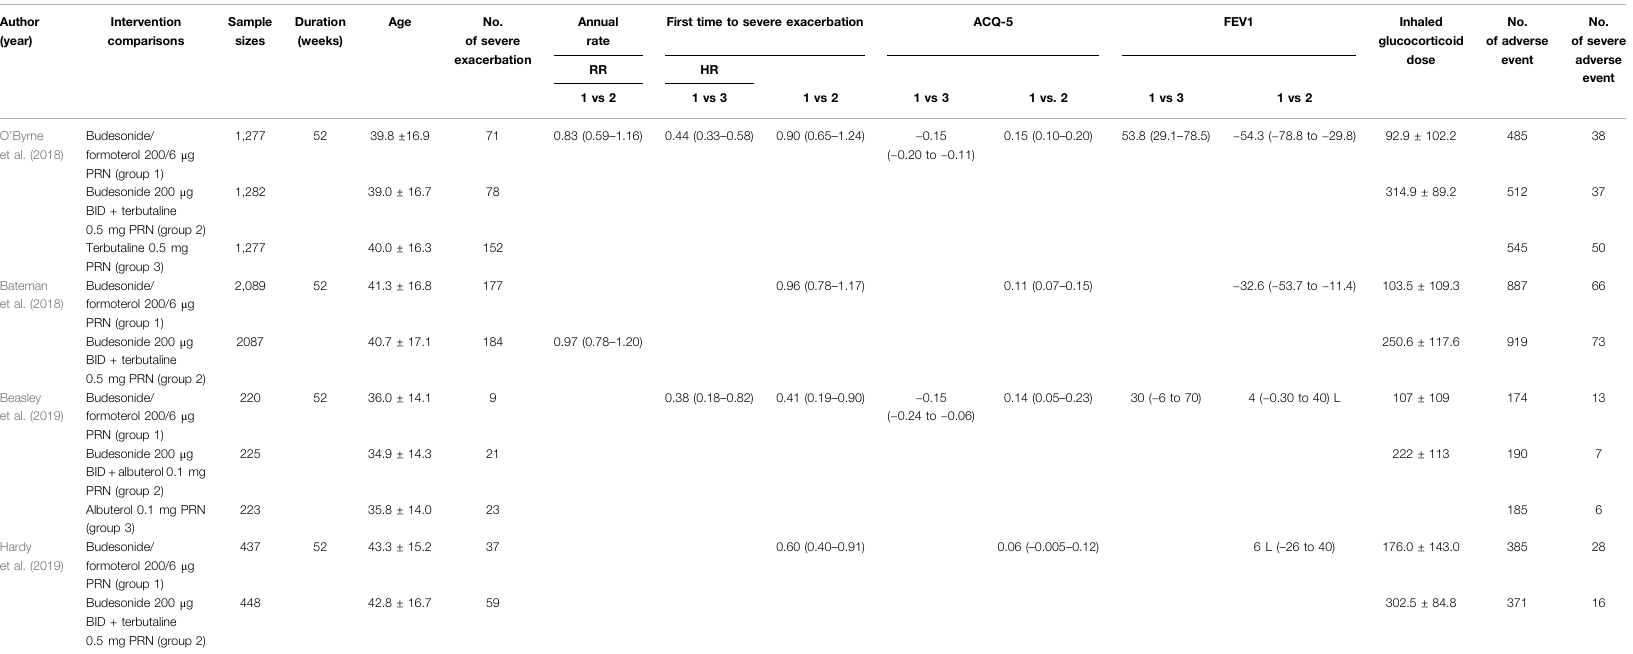
TABLE 1 | Characteristics of included